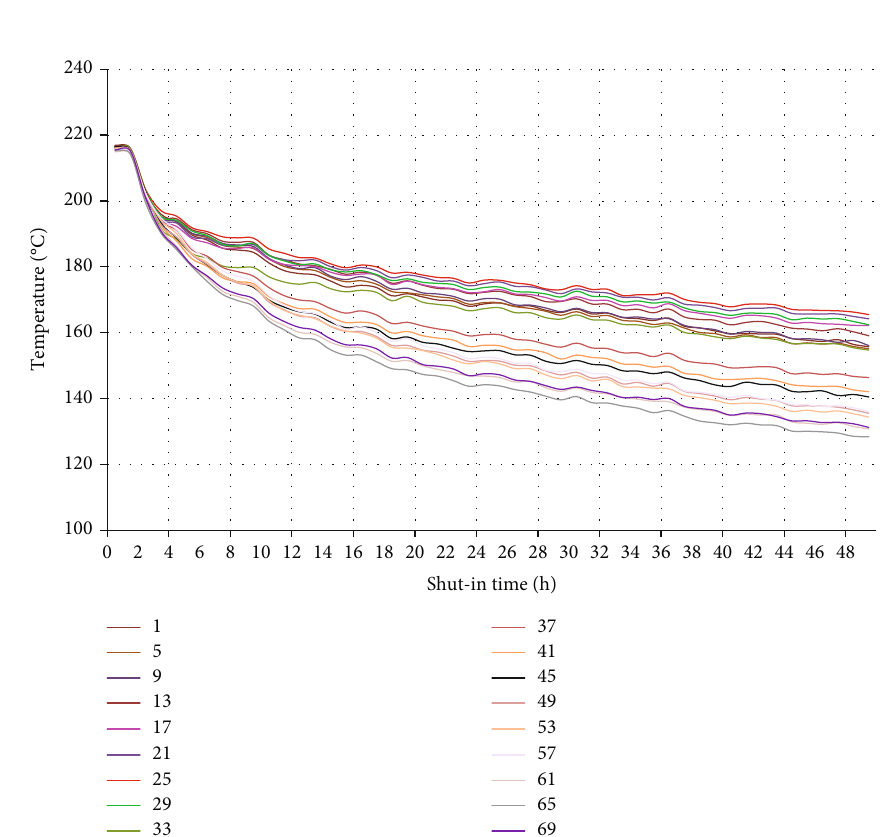
Figure 6: Temperature fall-o ff curves of partial measuring points along horizontal section.